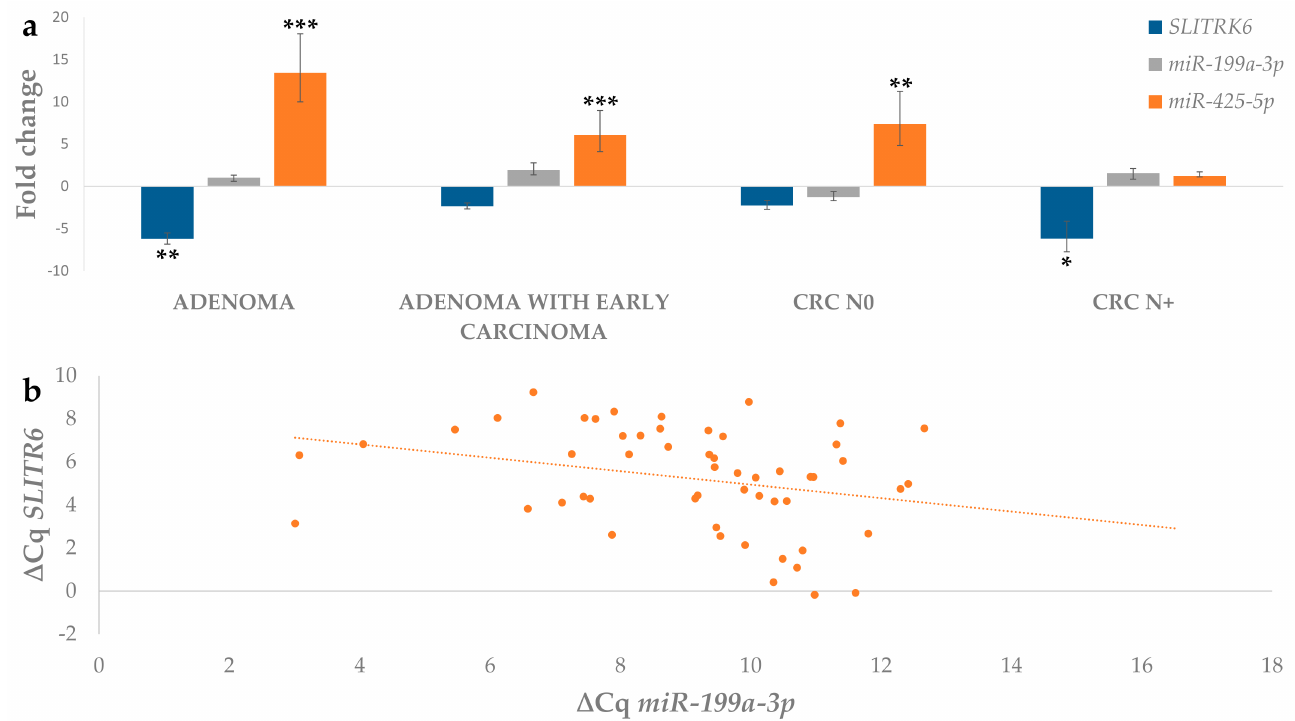
Figure 9. ( a ) Expression of SLITRK6 , miR-199a-3p and miR-425- 5p in adenoma, adenoma with early carcinoma and carcinoma without and with lymph node metastases; ( b ) Correlation between expression ( ∆ Cq) of miR-199a-3p and target gene SLITRK6 . Legend: CRC N0, colorectal carcinoma without lymph node metastases; CRC N+, colorectal carcinoma with lymph node metastases; * p ≤ 0.05; ** p ≤ 0.01; *** p ≤